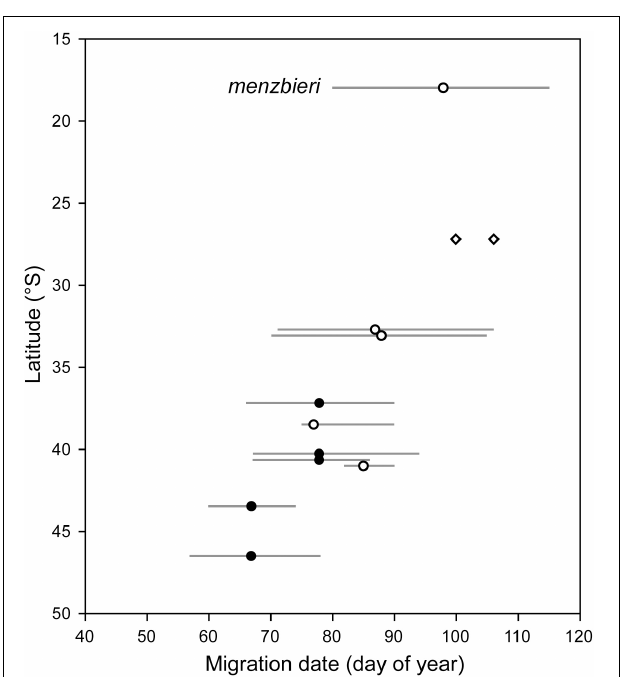
FIGURE 10 | Variation in timing of northward departure by bar-tailed godwits across non-breeding latitudes in New Zealand (filled circles) and Australia (open circles). For each site, line indicates range of departure dates directly observed or inferred from flock counts, and circle indicates date when ca. 50% of local population had migrated. Data sources: Battley, 1997; Wilson et al., 2007; this study. Diamonds indicate departures from Moreton Bay, Australia by two PTT-tracked godwits in 2019; both were tracked to breeding sites in northernmost Alaska (Z. Ma, personal